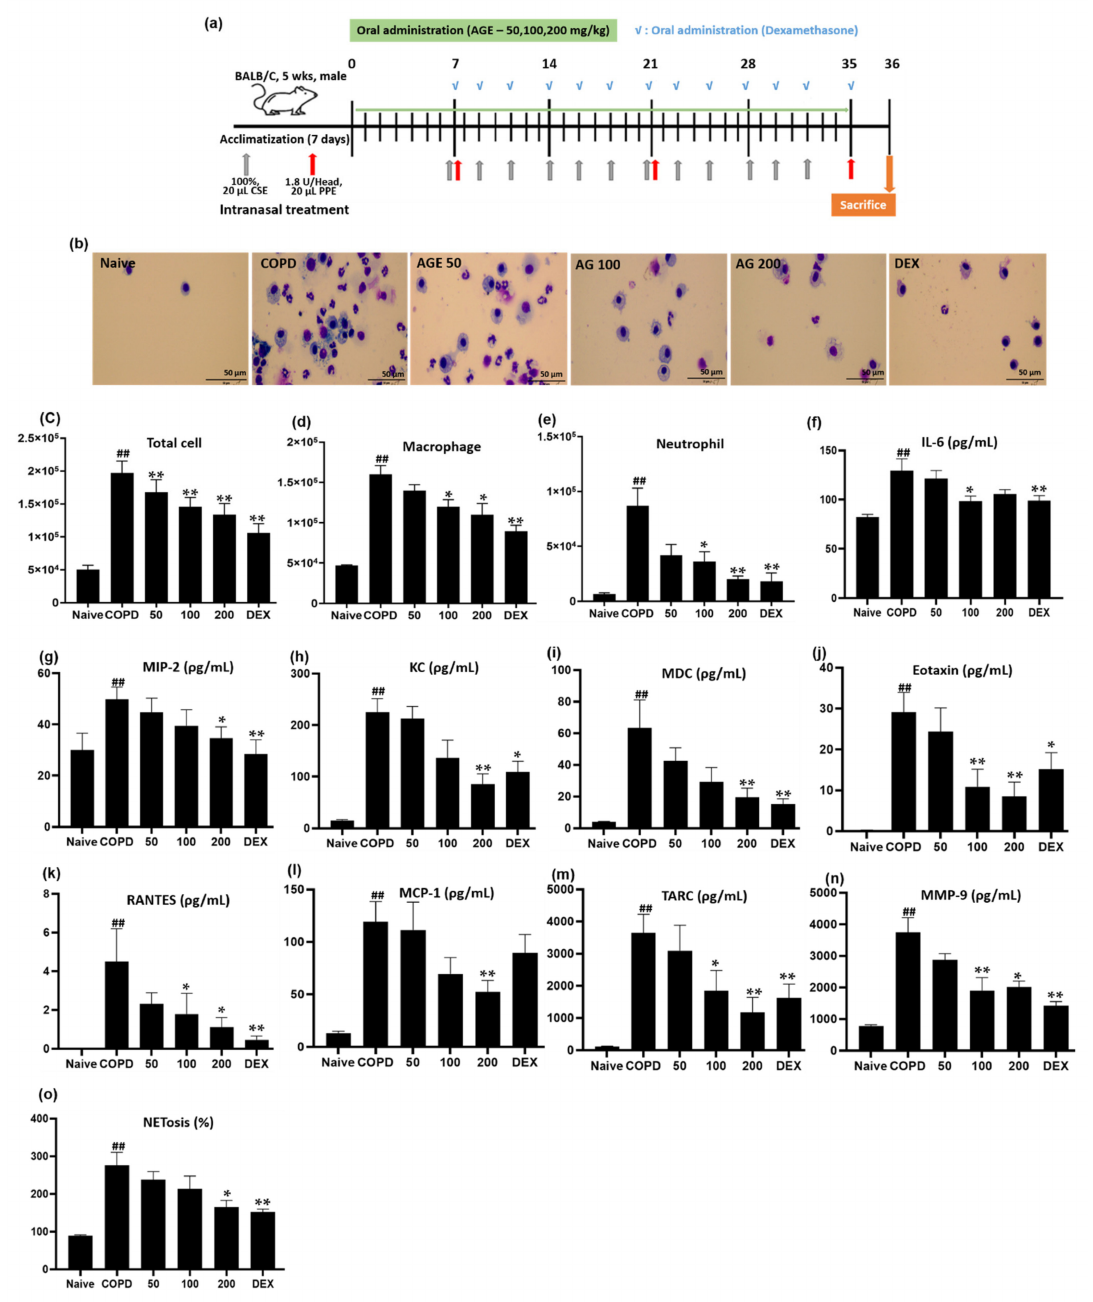
Figure 4. Effect of the Artemisia gmelinii ethanol extract (AGE) on the the inflammatory cell count and the production of cytokines and chemokines in bronchoalveolar lavage fluid (BALF) from the CSE/PPE-induced chronic obstructibe pulmonary disease (COPD) model. ( a ) The timeline of mouse CSE/PPE sensitizaion and oral administration. Cell infiltration ( b ) was measured by Diff-quick stain methods (scale bar: 50 µ m) and all images were taken at × 400 magnification. The total cells counts ( c ) were assessed by automatic cell counter. The number of macrophages ( d ) and neutrophils ( e ) was counted from microscopy images. The levels of IL-6 ( f ), MIP-2 ( g ) and MMP-9 ( n ) proteins were measured by ELISA and the levels of KC ( h ), MDC ( i ), eotaxin ( j ), RANTES ( k ), MCP-1 ( l ), and TARC ( m ) were analyzed by Q-plex. NETosis ( o ) was determined by Sytox Green fluorescence. Data are presented as means ± SD. The significant differences among the groups were analyzed using one-way analysis of variance by Bonferroni’s test (## p < 0.01 compared to the control group; * p < 0.05 and ** p < 0.01 compared to the CSE + LPS-stimulated